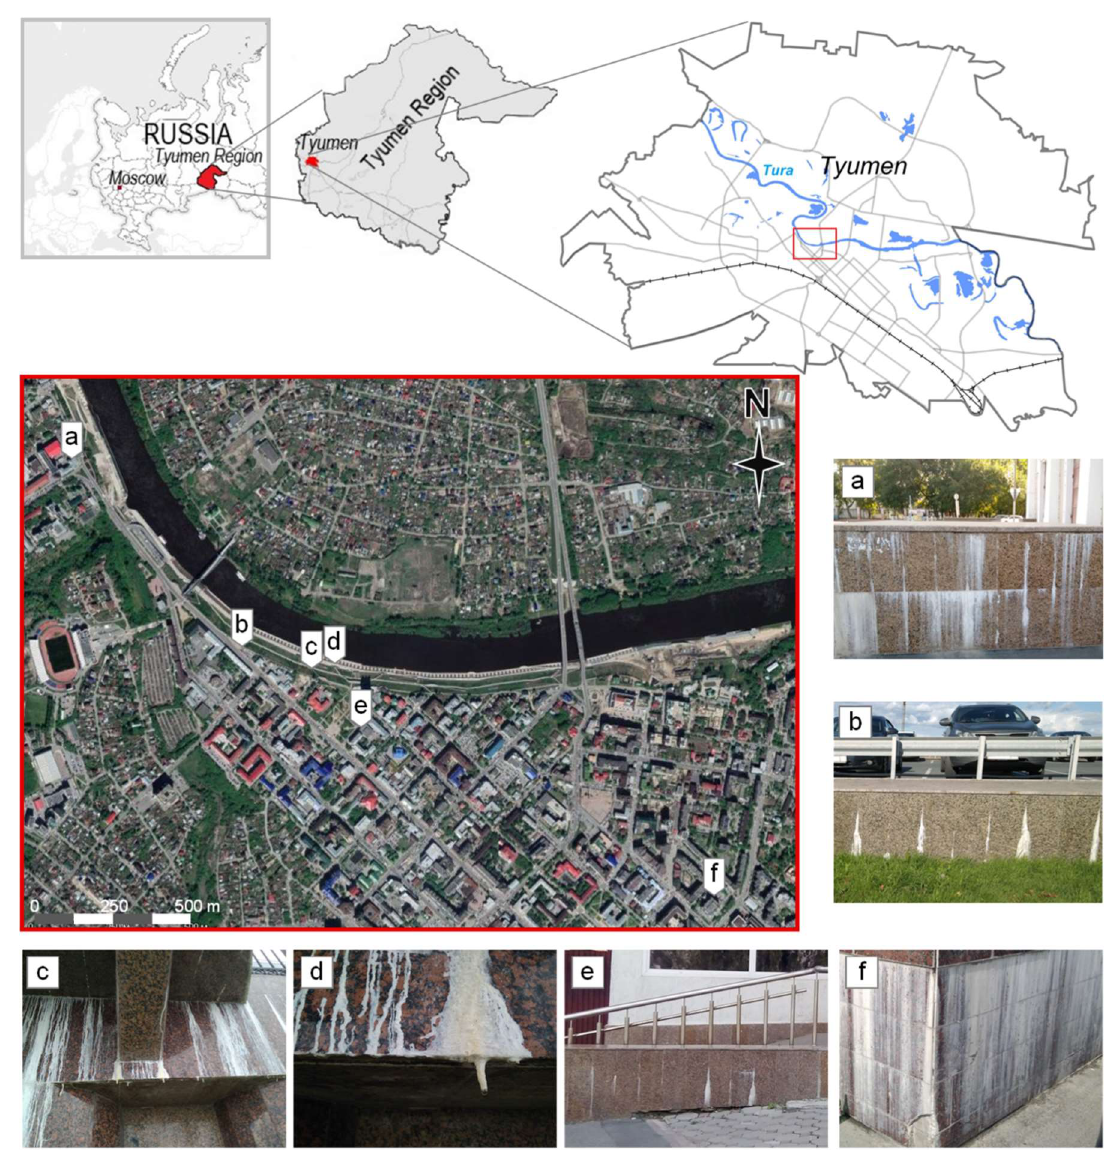
Figure 1. Location of the objects of study and photographs of carbonate neoformations on the facades of buildings and engineering structures of Tyumen: ( a ) crusts on the porch of the building of the Tyumen Industrial University; ( b ) crusts on the upper level of the Tura River embankment; ( c ) crusts on the lower levels of the Tura River embankment; ( d ) stalactite-like bodies of the second and third levels of the embankment; ( e ) crusts on the facades of the restaurant “Na Tsarskoi”; and ( f ) crusts on the facades of the Department of Mineral Resources and Ecology of the Tyumen Region.